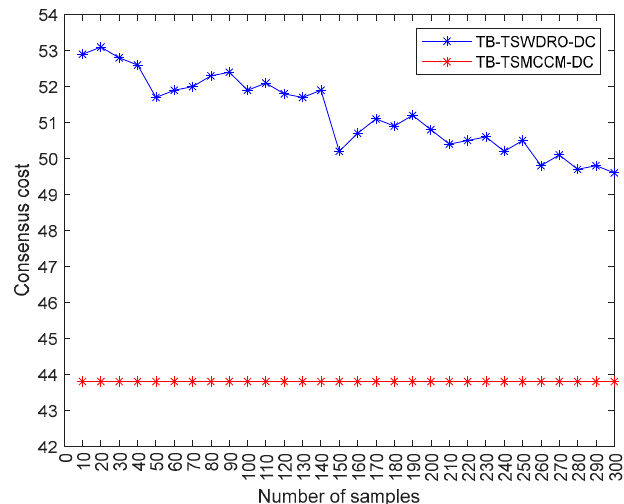
Figure 3. Comparison of the TB-TSWDRO-DC and TB-TSMCCM-DC results.